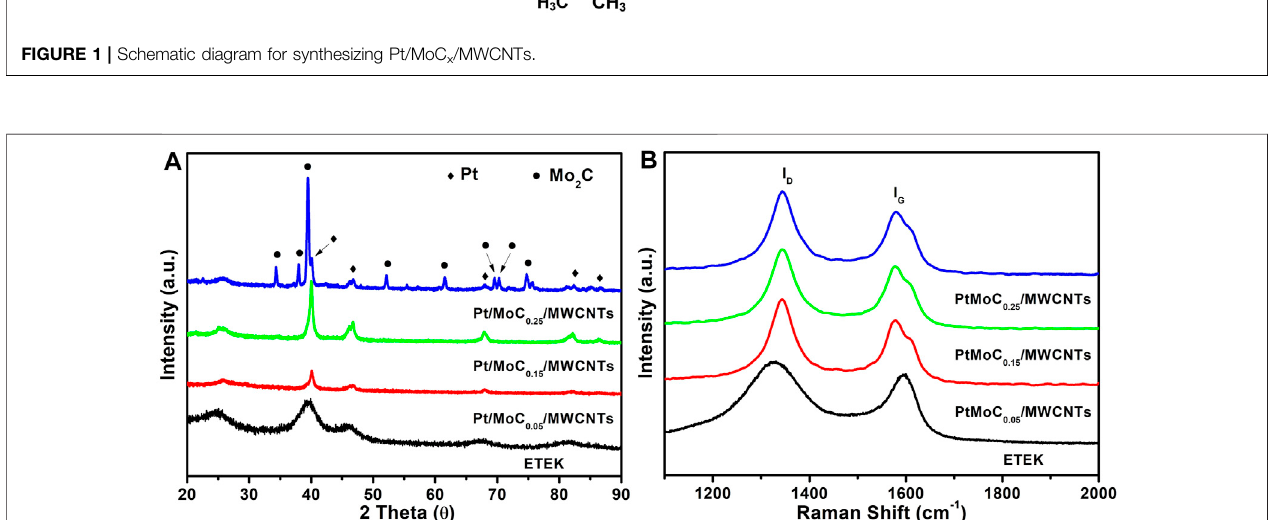
FIGURE 2 | (A) Wide-angle XRD patterns and (B) Raman spectra of ETEK and Pt/MoC x